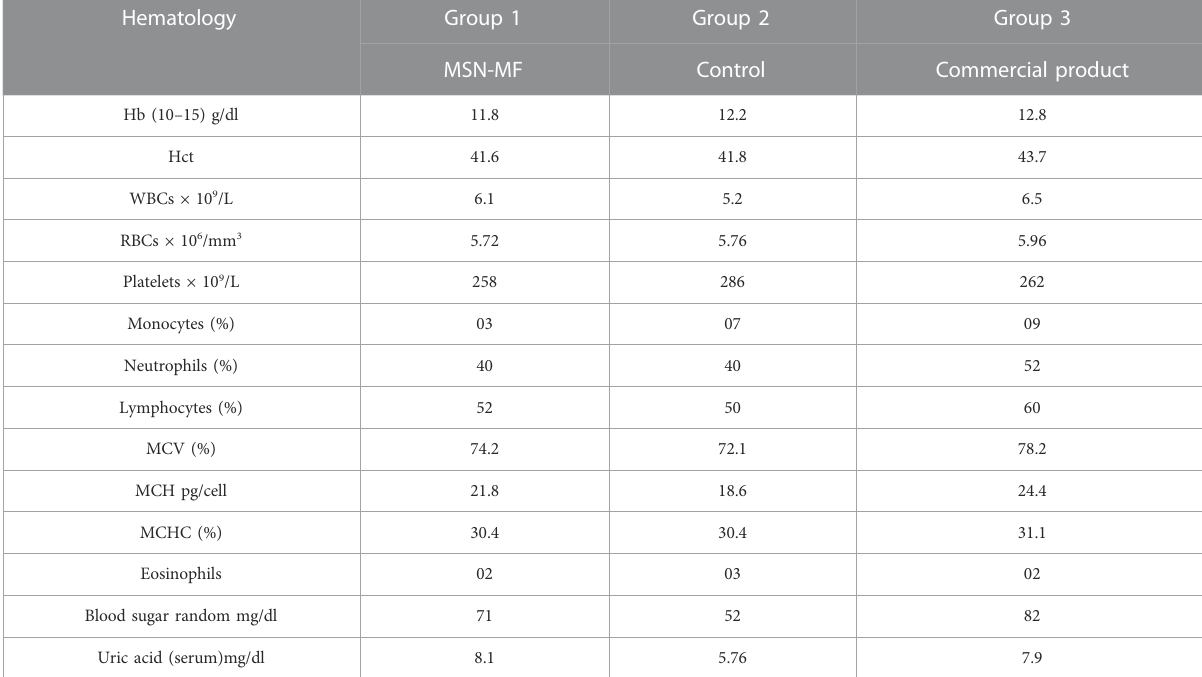
TABLE 2 Biochemical blood analysis.